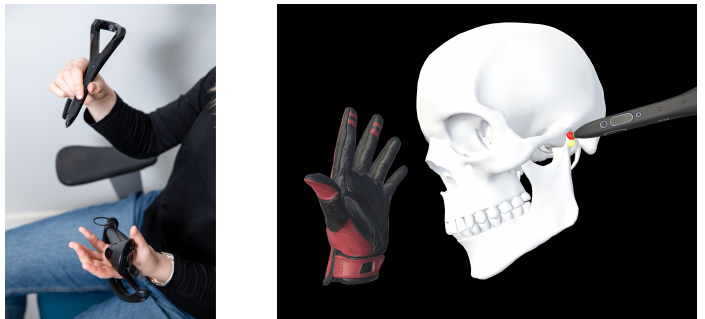
Figure 3. Controller interaction method outside VR ( left ). Stylus marking method inside VR and the study task ( right